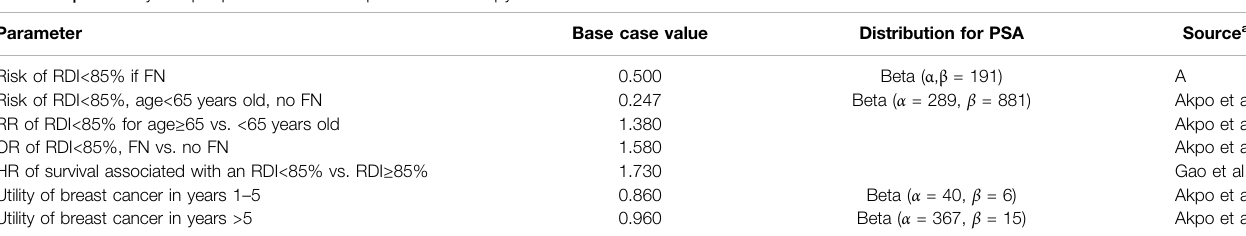
TABLE 2 | Summary of input parameters for the post-chemotherapy